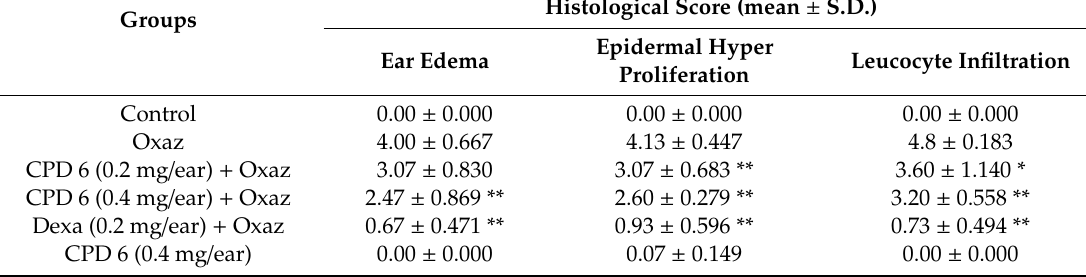
Table 2. E ff ect of CPD 6 on histological inflammatory observations in oxazolone-induced chronic